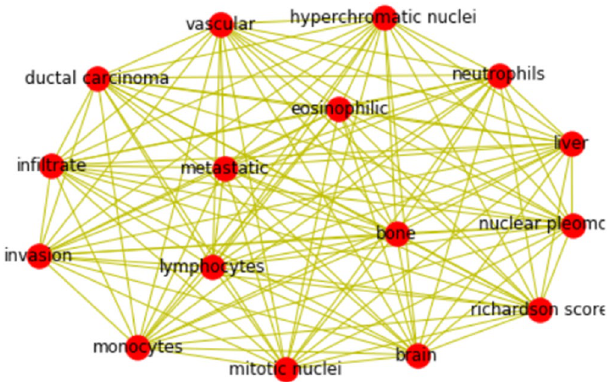
Figure 7. The Word Cloud Generator Based on Text Network Visualization. Closely located words represent terms frequently used together to classify